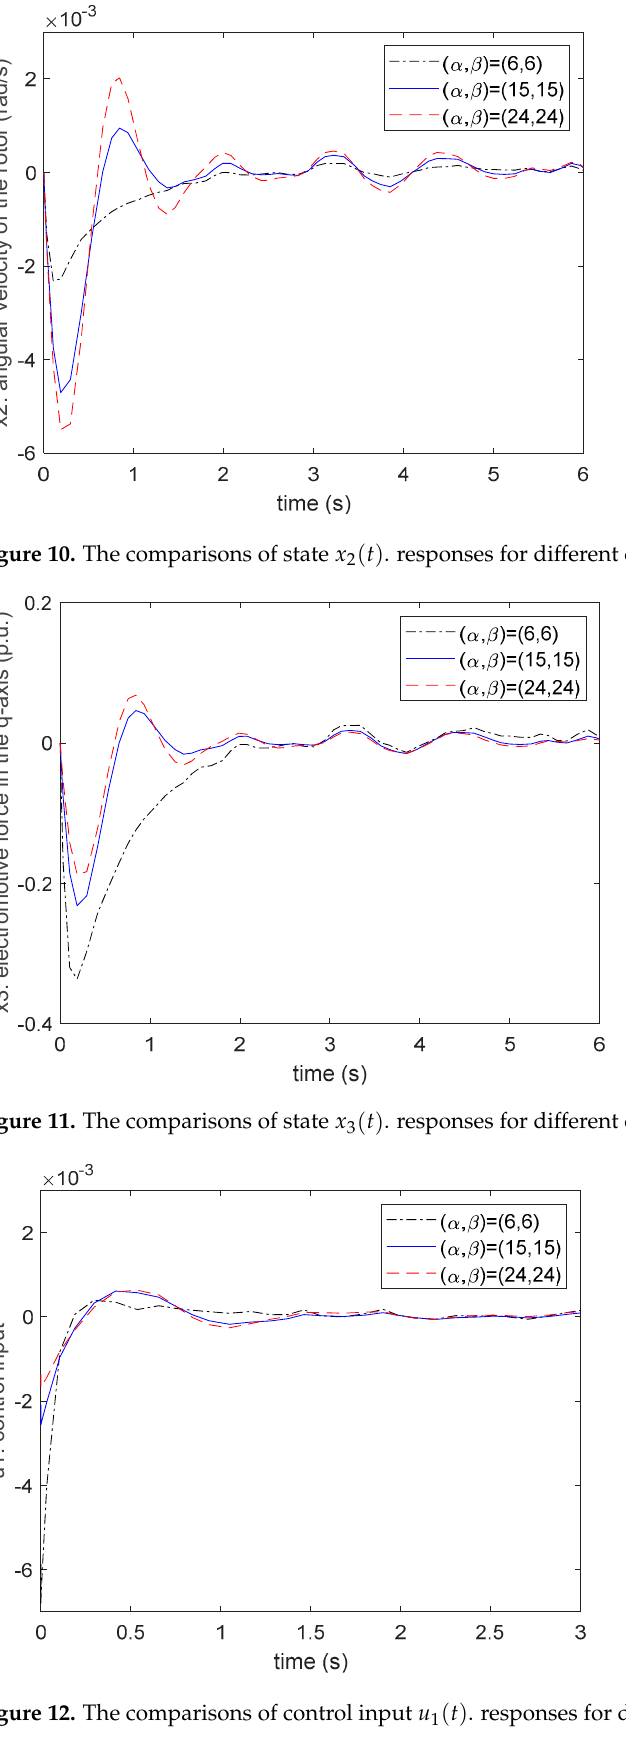
u t responses for different circle regions. Figure 12. The comparisons of control input u ( t ) . responses for different circle 1 1